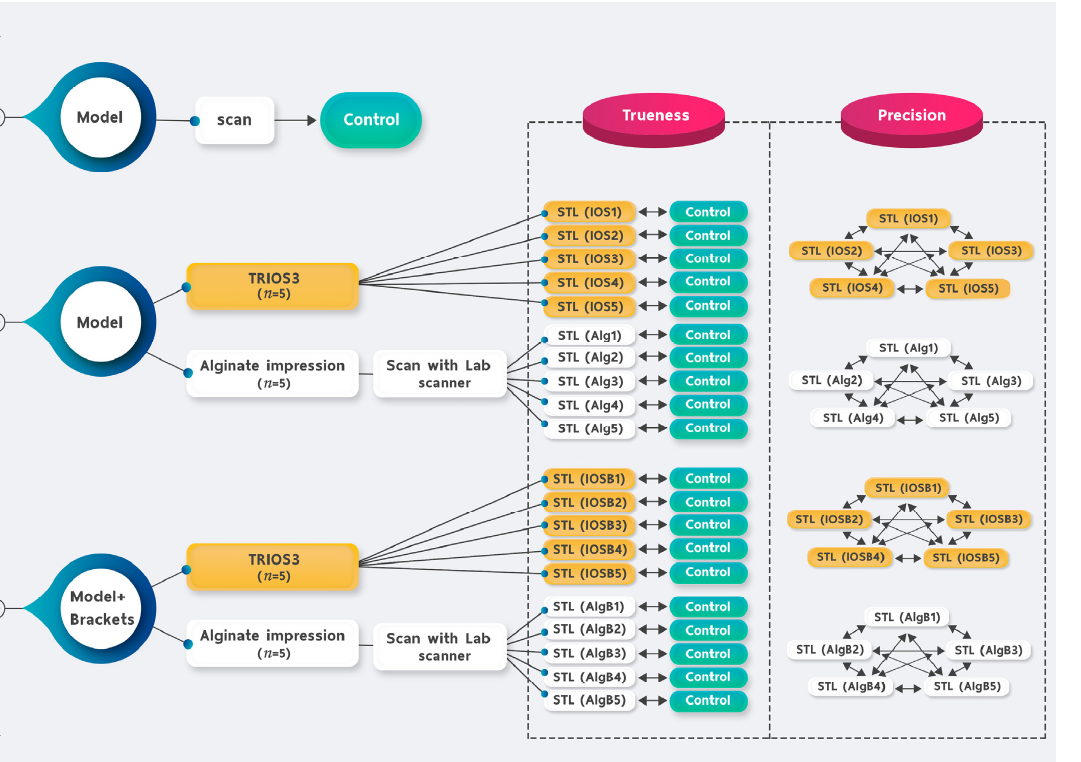
Figure 1. The flow chart shows experimental details.